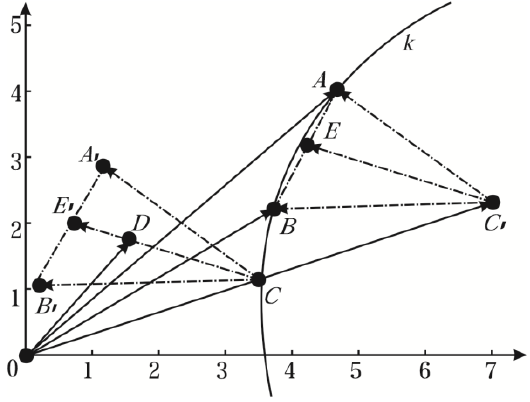
Figure 4. Disperse